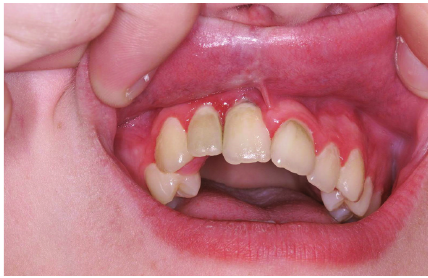
Figure 5: Linear morphea of the mouth. Note subtle changes of the inner upper lip and gingival mucosa around the maxillary right central